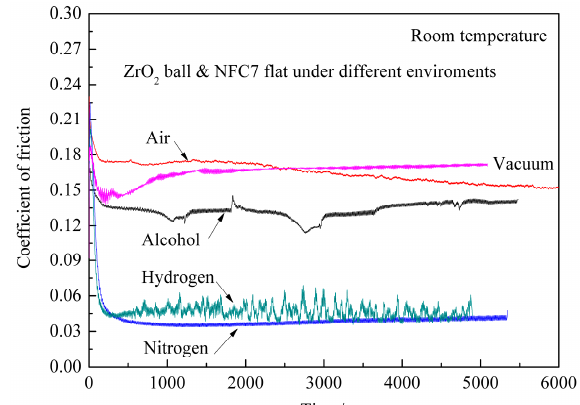
Figure 2. CoF of ZrO 2 ball/DLC (Diamond like carbon) films under various environments at room temperature.